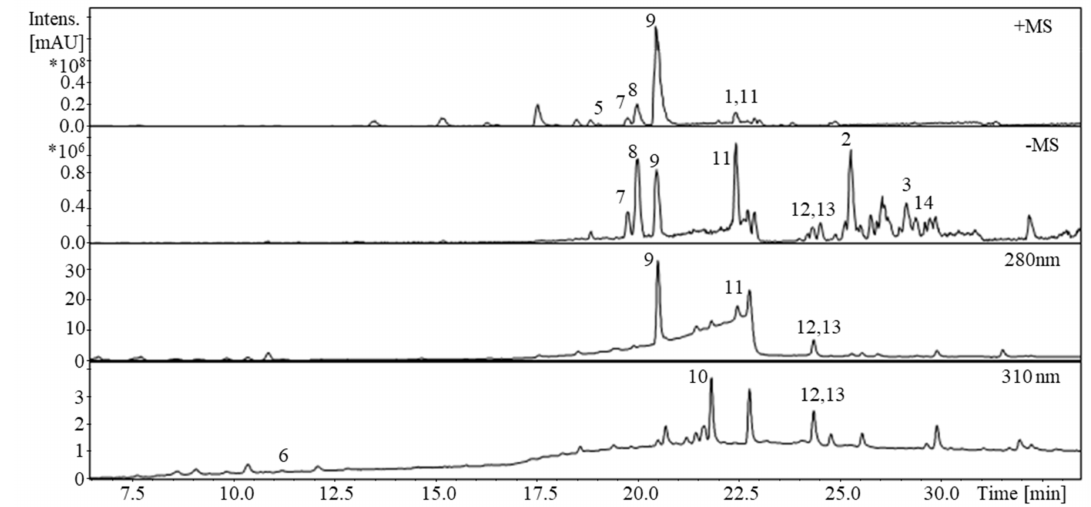
Figure 5. HPLC-UV-MS separation of the A. aerophoba extract. Peak assignment is according to Figure 1. Stationary phase: Synergi Polar-RP 80A (250 × 4, 6 mm; 4 µ m) from Phenomenex (Torrance, CA, USA); mobile phase: 0.1% ( v/v ) FA in water (A) and CH 3 CN (B); Gradient: 0 min: 2% B, 10 min: 15% B, 18 min: 50% B, 30–35 min: 98% B, 35.1–45 min: 2% B; λ = 210, 254, 280, 310, and 350 nm; flow rate = 0.7 mL/min; T = 22 ◦